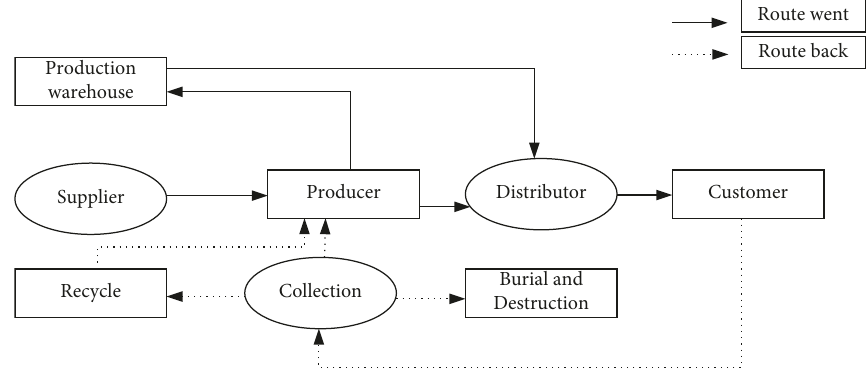
Figure 1: Proposed supply chain